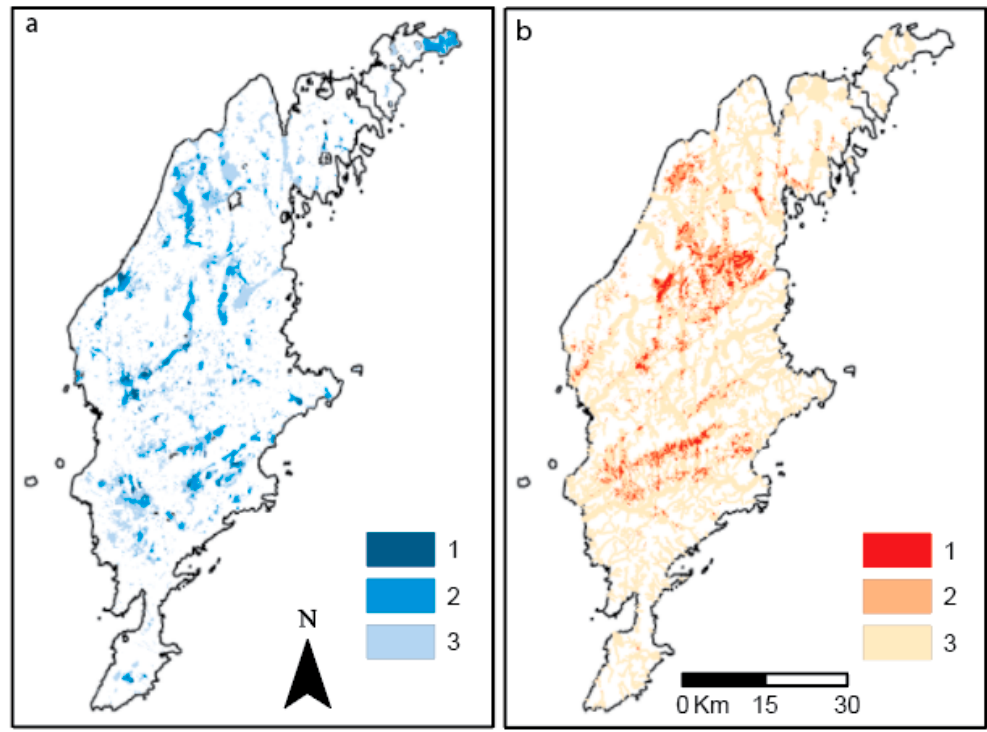
Figure 2. Maps of the combined GIS analysis. ( a ) Areas suitable as infiltration areas and for groundwater storage; ( b ) Areas close to a natural source (intermittent stream, perennial river, lake) and for construction of surface storage areas (dams). Data has been reclassified into classes; lower numbers more suitable.